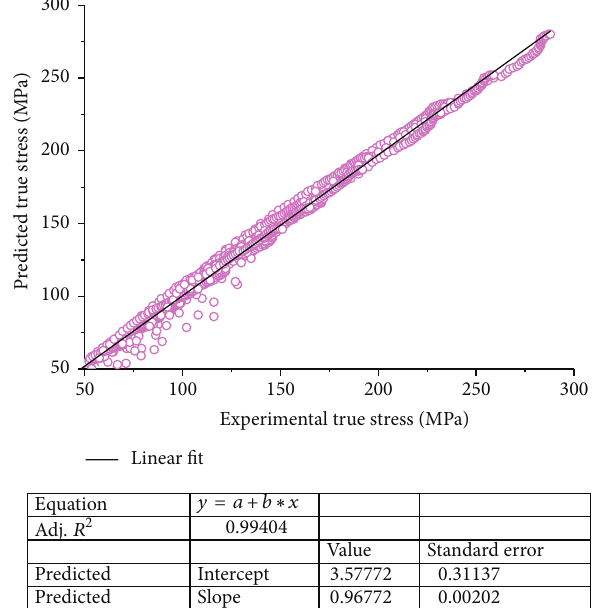
Figure 7: The plot of predicted versus experimental stress for the developed model.